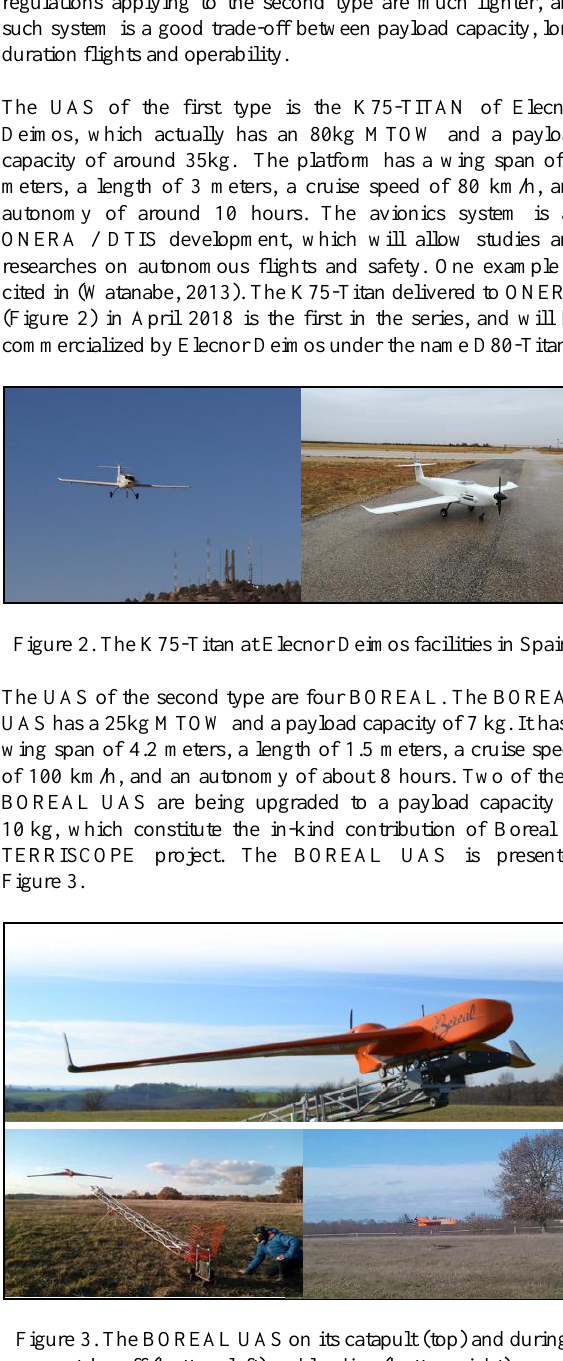
Figure 1. The ATR42 (top, © DR Safire - J-C. Canonici), PA23 (bottom left, © DR Safire/Météo-France - JM Destruel) and the Stemme S10-VT of ONERA (bottom right)